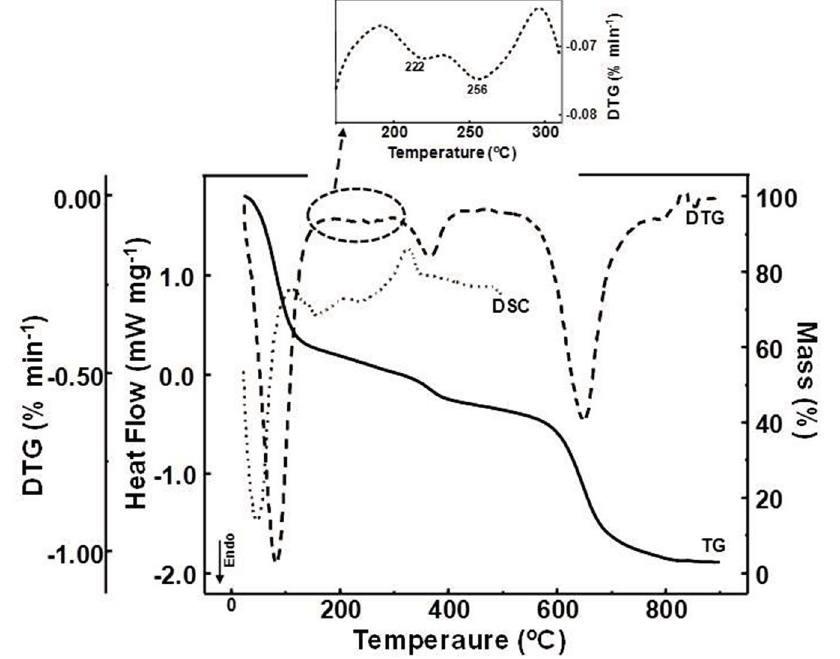
Figure 1. TG/DTG and DSC curves of phytic